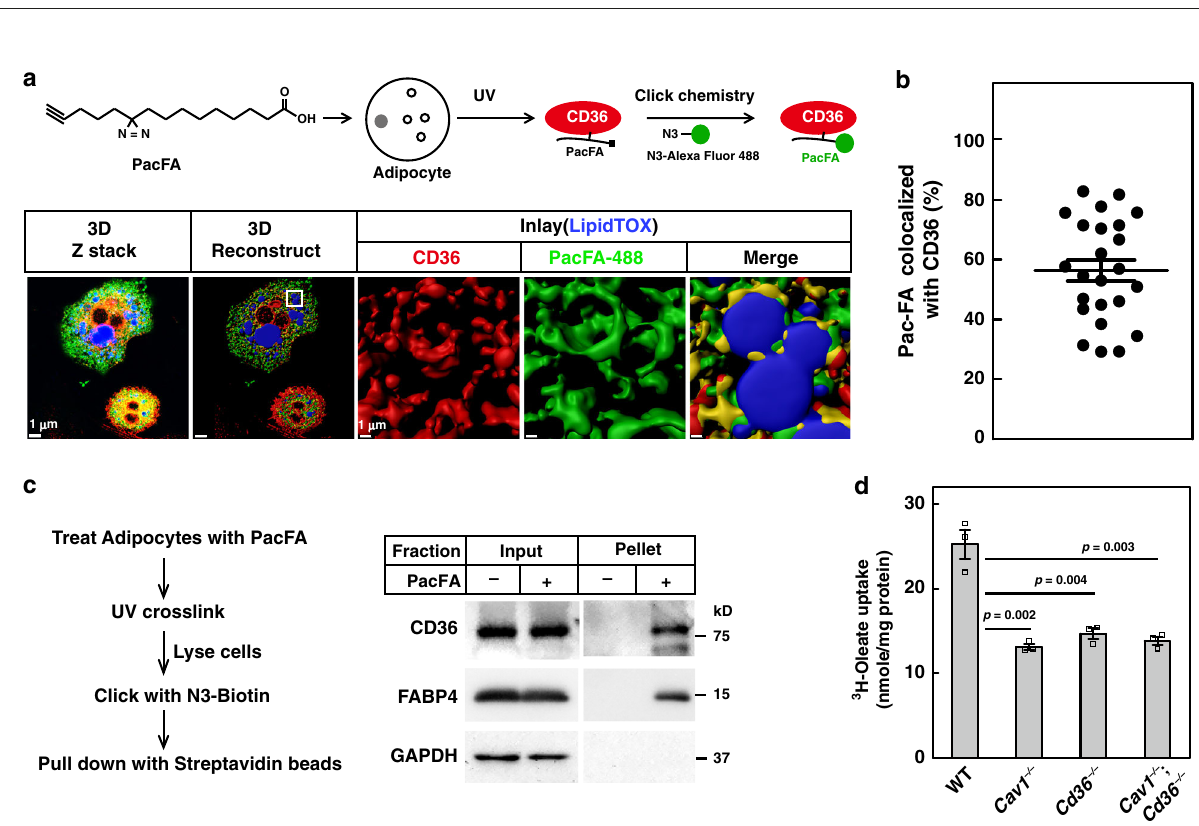
Fig. 1 FAs trigger internalization of CD36. a , b On day 8 of differentiation, 3T3-L1 adipocytes were pretreated with serum-free medium for 4 h, and then treated with BSA-conjugated oleate (100 μ M) for indicated time. a One set of cells was subjected to immunostaining with anti-CD36 and anti-CAV1 antibodies. LipidTOX was used to label lipid droplets. Images were taken under a Zeiss LSM-780 microscope in a 3D Z-stack mode and reconstructed using Imaris 9.2.0. b The other set of cells was subjected to surface biotinylation assay and blotted with indicated antibodies. c , d On day 4 of differentiation, 3T3-L1 cells were infected with lentivirus encoding scrambled shRNA or shRNAs against CD36 or CAV1. On day 5, cells were selected with 5 μ g/ml puromycin. On day 8, cells were pretreated as in ( a ) and treated with oleate (100 μ M) for 4 h, followed by immunostaining with anti-CD36 and anti-CAV1 antibodies ( c ), or surface biotinylation assay ( d ). e , f 3T3-L1 adipocytes were pretreated as in ( a ) and treated with BSA-conjugated FAs with different chain lengths or saturation (100 μ M) for 4 h. Cells were subjected to immunostaining with anti-CD36 antibody ( e ), or surface biotinylation assay ( f ). After oleate treatment for 4 h, 3T3-L1 adipocytes were switched to serum-free medium for indicated time and harvested for immunostaining ( g ) and surface biotinylation ( h ). The scale bars were as indicated in each fi gure. These experiments were repeated at least three times. Source data are provided as a Source Data fi le.